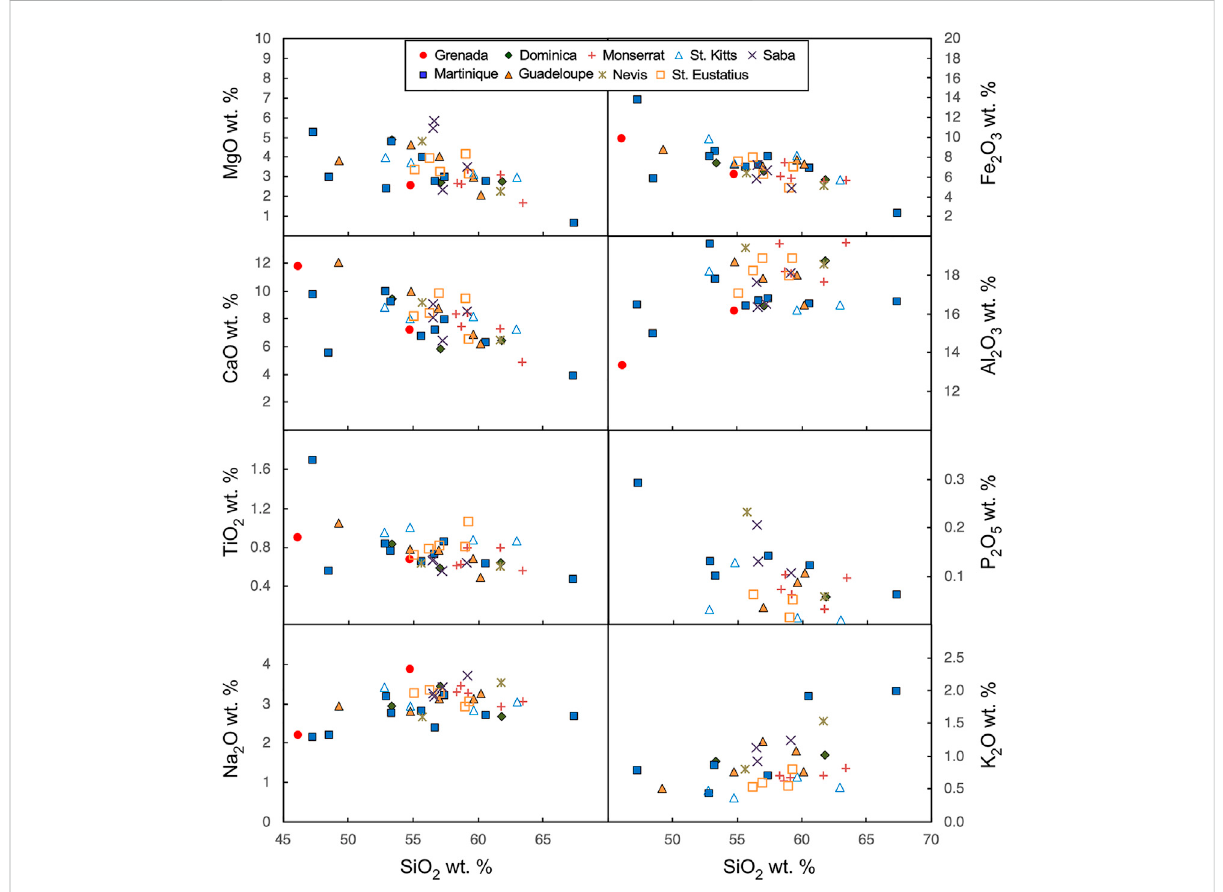
FIGURE 2 MajorelementvariationfortheLesserAntilles.DatafromthisstudyiscombinedwiththatofGermaetal.,2010,Germaetal.,2011,andLabanieh et al., 2010, Labanieh et al., 2012 for Martinique. LAIA samples form a quasi-continuous suite, whereas speci fi c islands on to themselves do not necessarily display differentiation